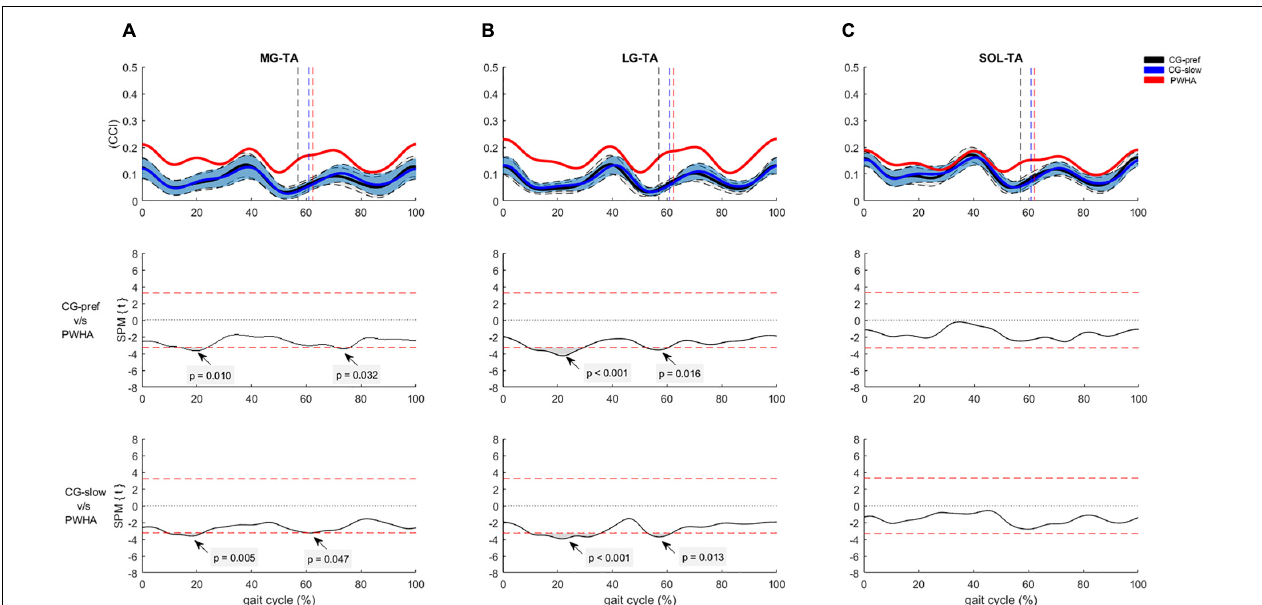
FIGURE 5 | Co-contraction of muscles crossing the ankle during gait. (A) Con-contraction index (CCI) between medial gastrocnemius and tibialis anterior (MG-TA). (B) CCI between lateral gastrocnemius and tibialis anterior (LG-TA). (C) CCI between soleus and tibialis anterior (SOL-TA). (Top row) CCI of muscles crossing the ankle of people with hemophilic arthropathy (PWHA; n = 14) at their preferred velocity (red), the control group ( n = 13) at their preferred velocity (CG-pref, black), and during the slow velocity condition (CG-slow, blue). Data are plotted as a function of normalized step time (0, heel strike) and expressed as mean with 95% confidence interval for CG. Vertical dashed lines indicate transition from stance to swing phase (black, CG-pref; blue, CG-slow; red, PWHA). (Bottom two rows) Time-dependent t values of the statistical parametric mapping (SPM) for groups comparison. Horizontal red dashed line indicates p = 0.05 level. Gray zones indicate regions with statistically significant differences. a.u, Arbitrary